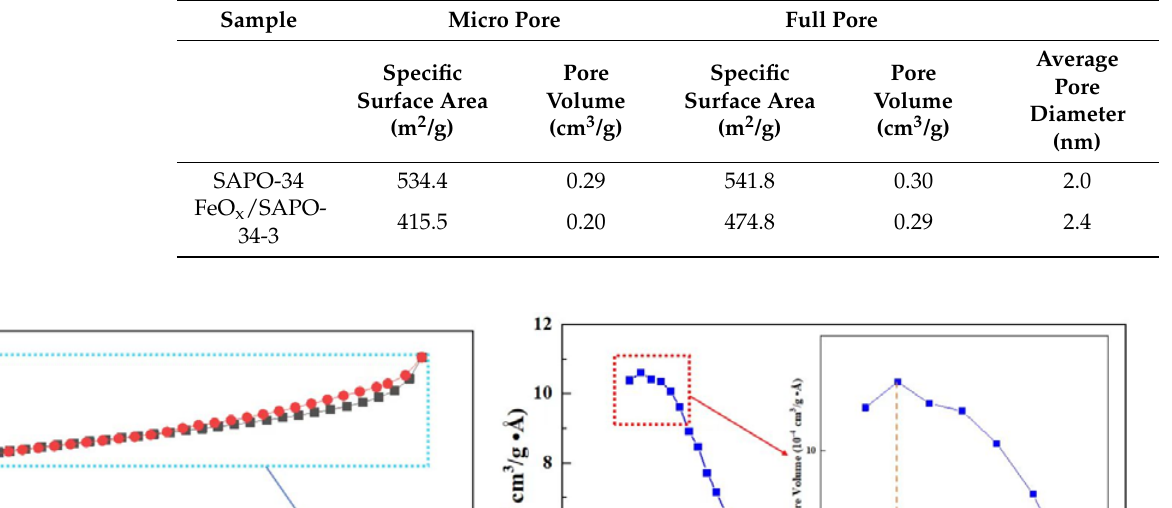
Table 1. Specific surface areas, pore volume and average pore diameter for all the catalysts.